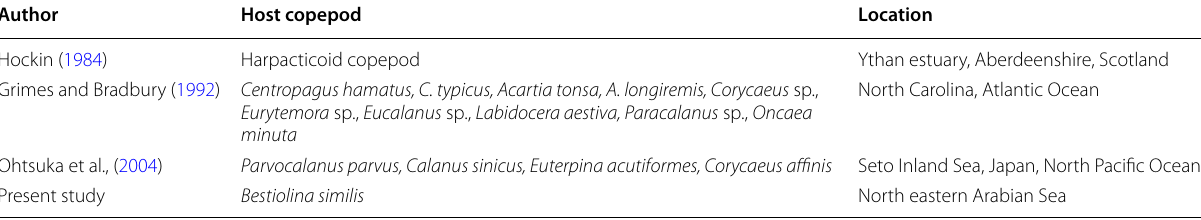
Table 2 Summary of previous information on Vampyrophrya pelagica